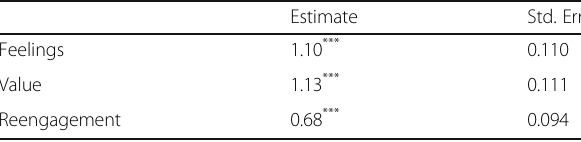
Table 6 Latent mean differences between biology and non- biology